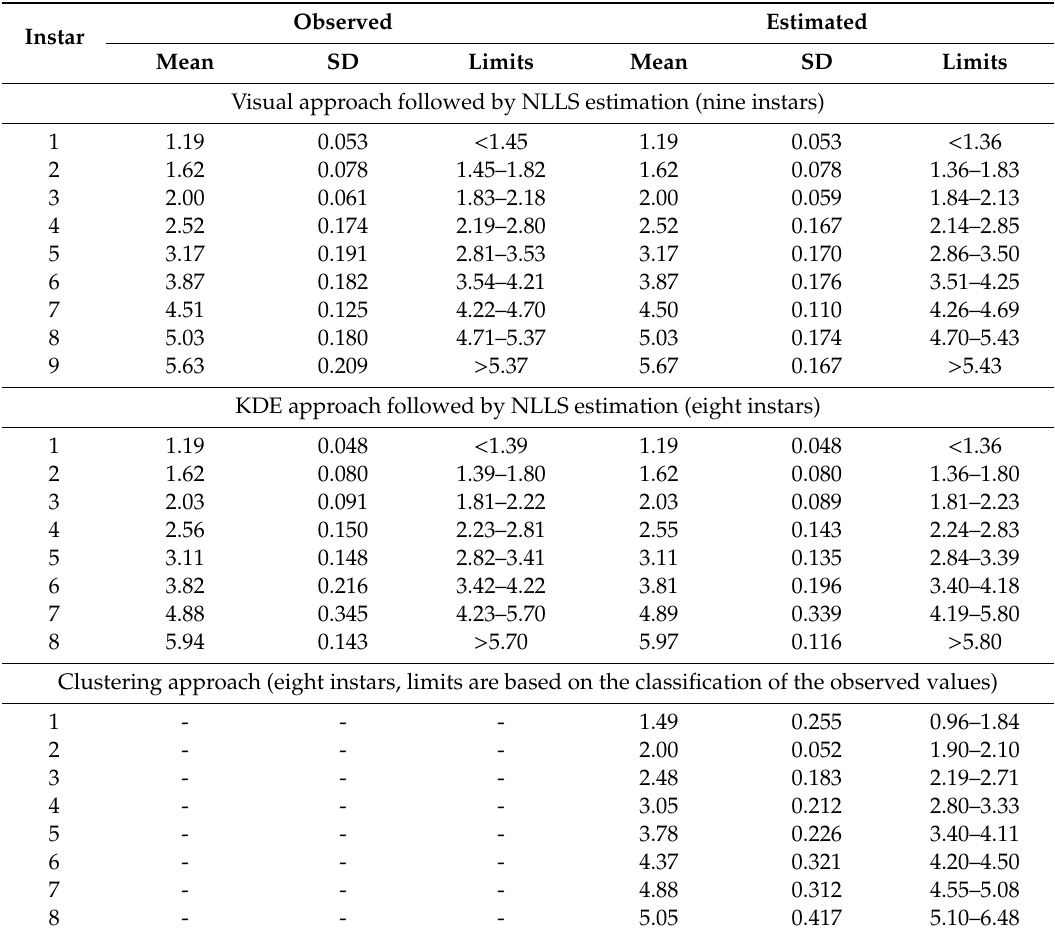
Table 2. Observed and estimated values for the means, standard deviations (SD), and limits of the head capsule widths (mm) of Dendrolimus pini larvae. Observed Estimated